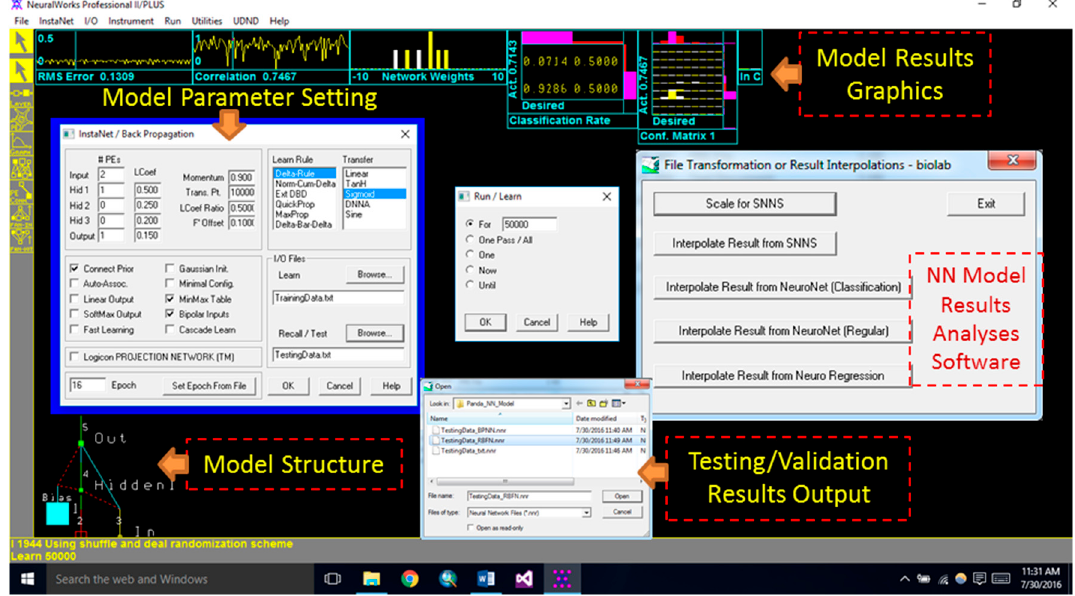
Figure 5. Visual representation of remotely sensed digital information based ET-estimation BPNN model architecture design, training model output graphics, and validation result interpolation (software) process.